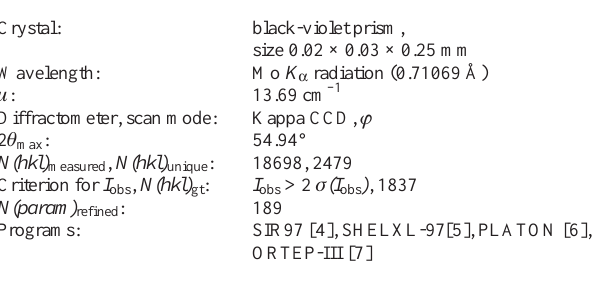
Table 1. Data collection and handling.